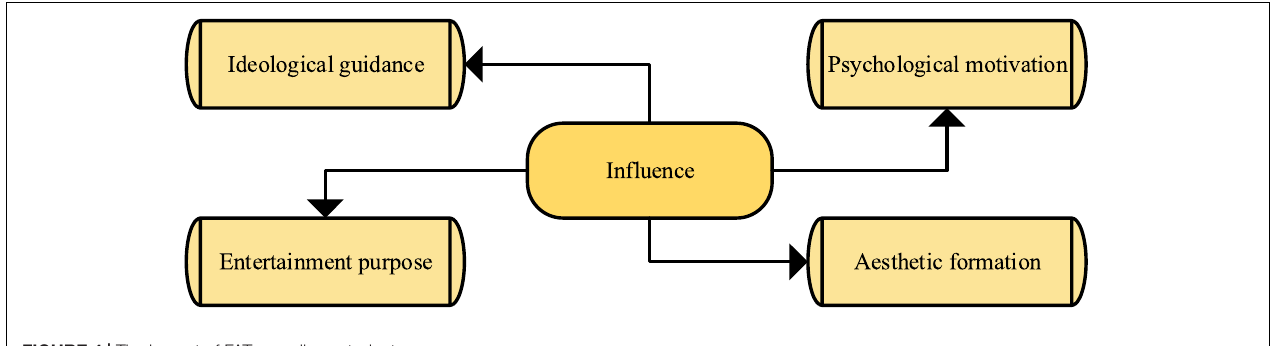
FIGURE 4 | The impact of FAT on college students.